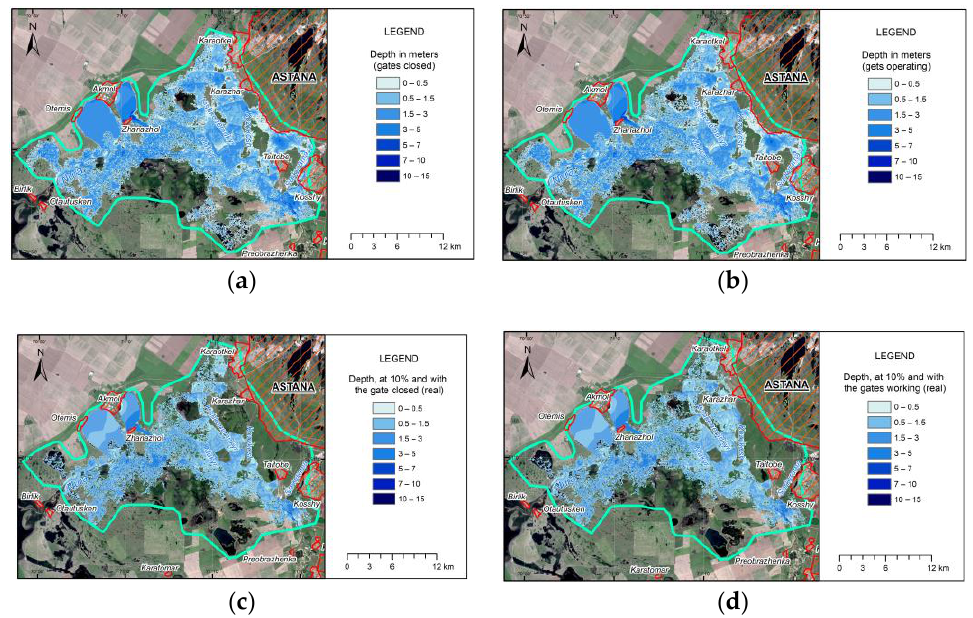
Figure 11. Maximum depth distribution during 100 – year ( a , b ) and 10 – year ( c , d ) return period hydrographs with closed gates and controlled gates, depth in meters. Table 3. Distribution of areas according to flood depths during different flood hydrographs, sq. km.